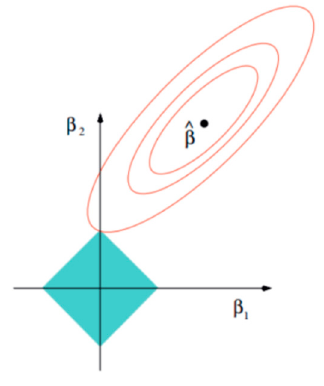
Figure 4. Lasso 2D model space.